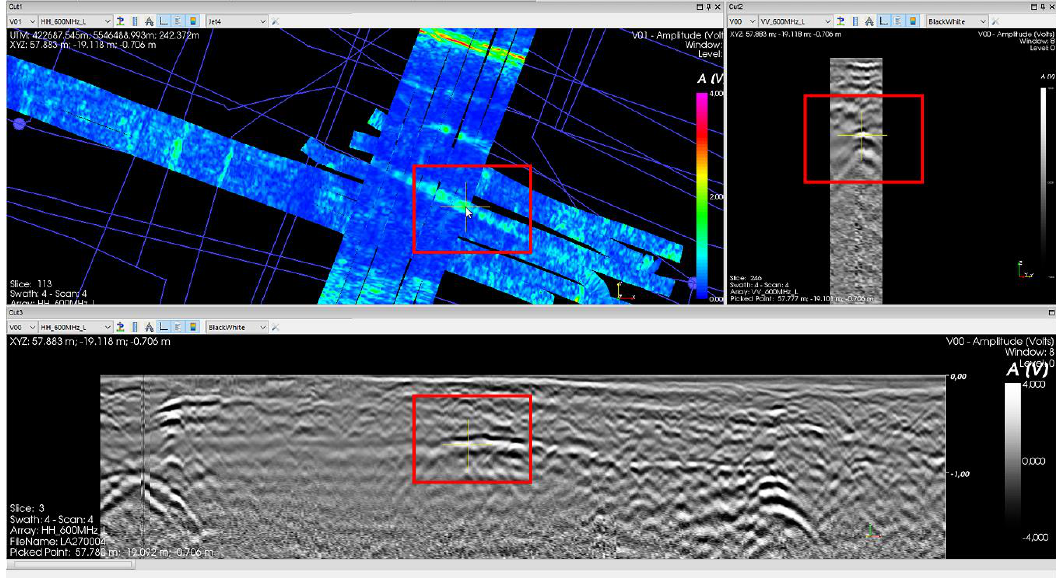
Figure 5. Workspace of GRED HD 3D module.